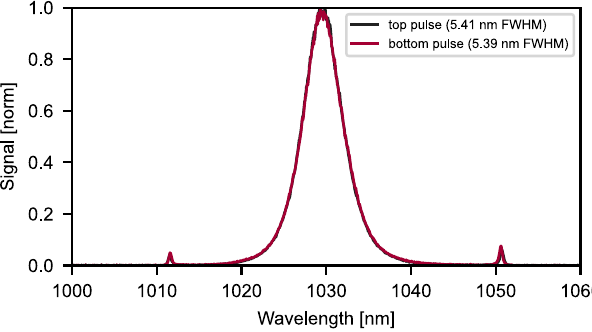
Fig. 2 Spectral characteristics of the emitted pulses. In black, the spectrum of “ top pulses ” , marked with red circle in Fig. 1c, is displayed. In red, the spectrum of “ bottom pulses ” , marked in Fig. 1c with a blue circle, is shown.